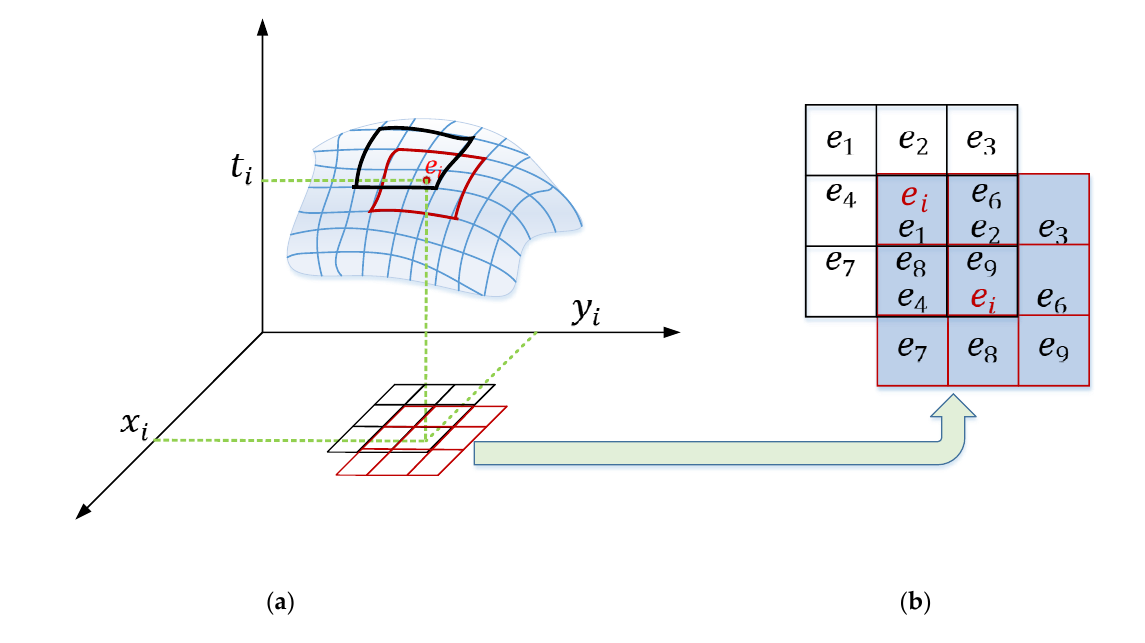
Figure 5. ( a ) The time surface of event; ( b ) the red and black squares in the event time surface map to the x, y plane.